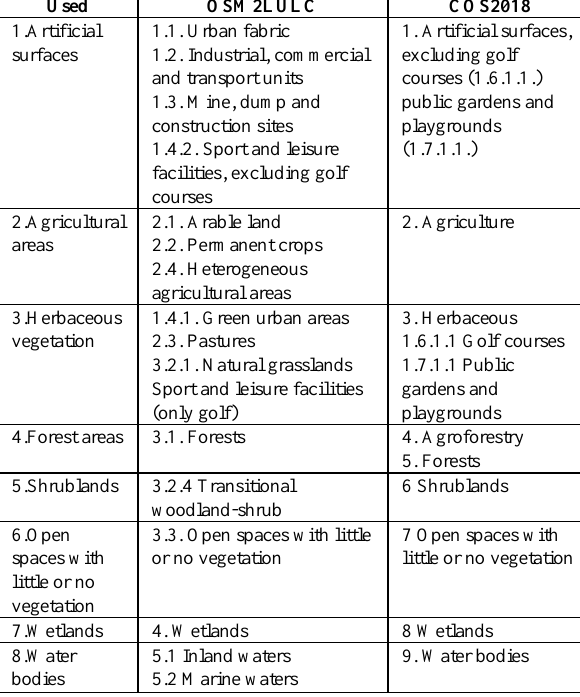
Table 2. Nomenclature relations between the nomenclature used in this paper, the nomenclature coming from OSM2LULC